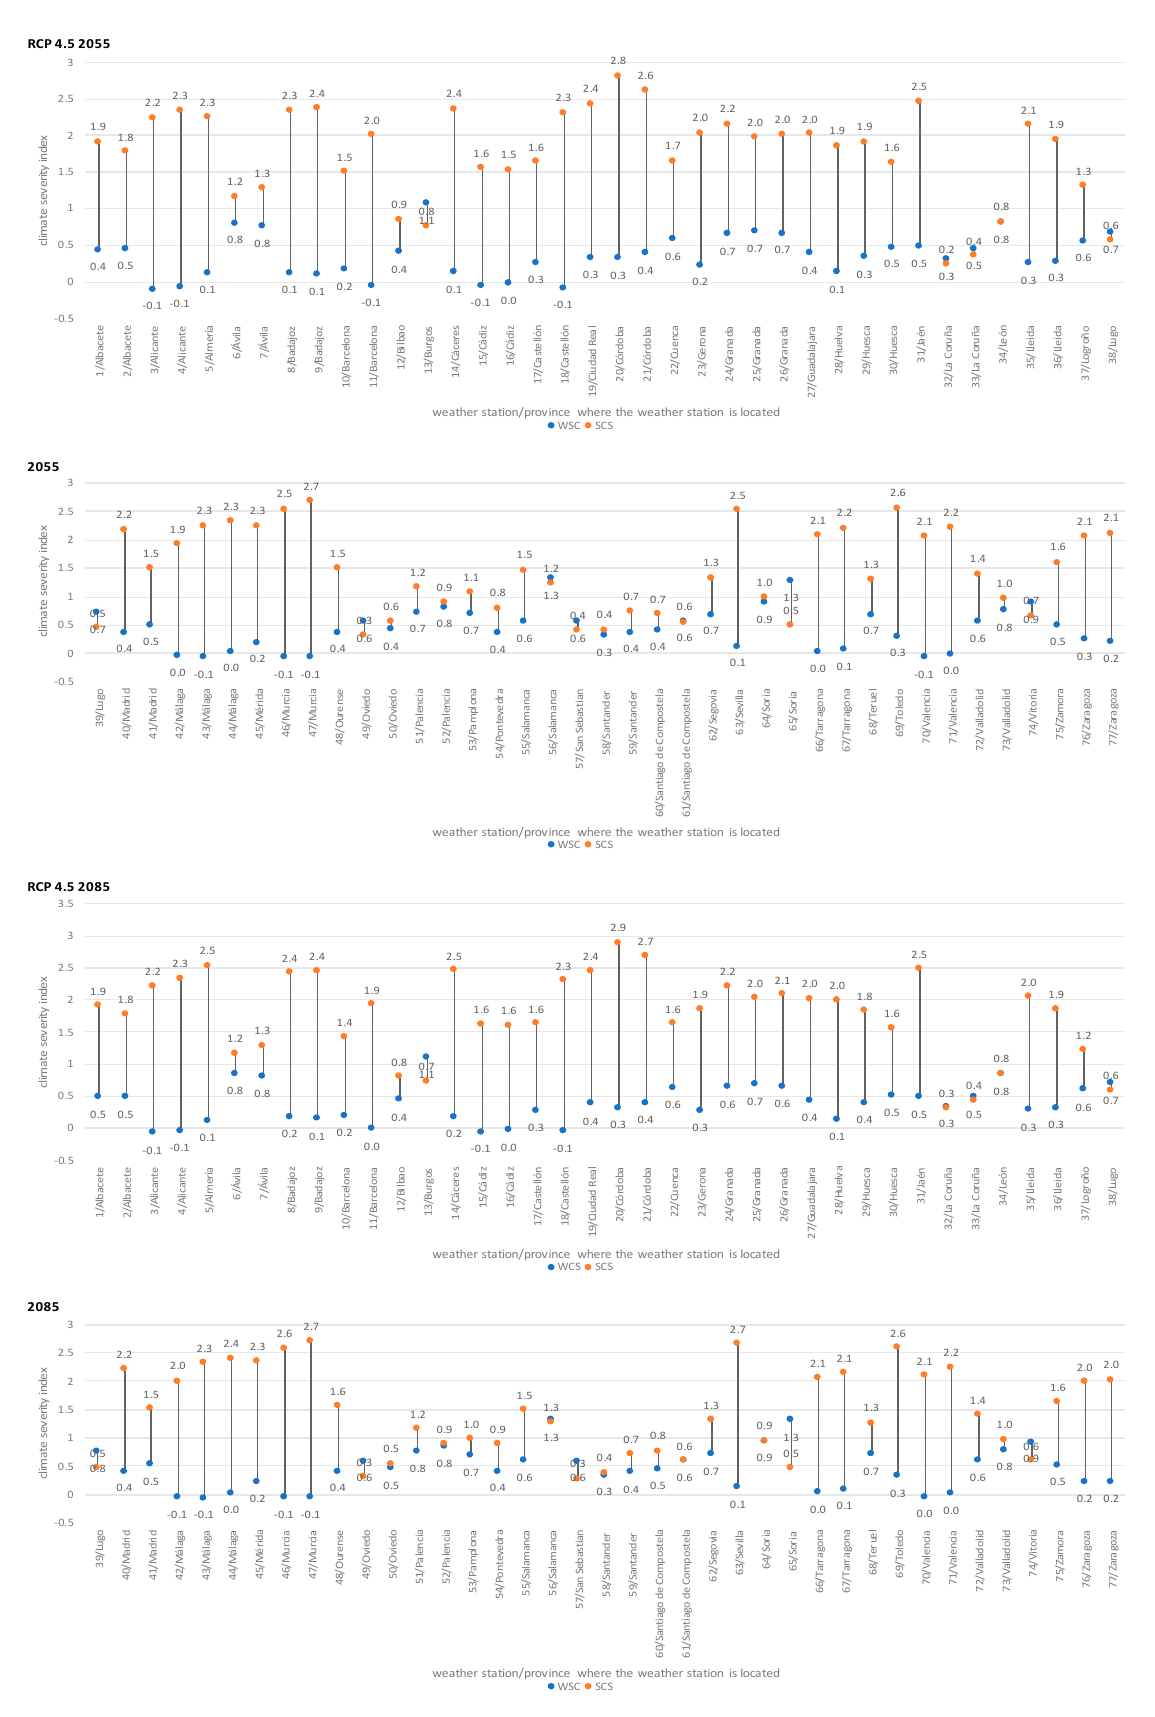
Figure 3. Calculated indices of winter (WCS) and summer (SCS) climate severity for the RCP 4.5.